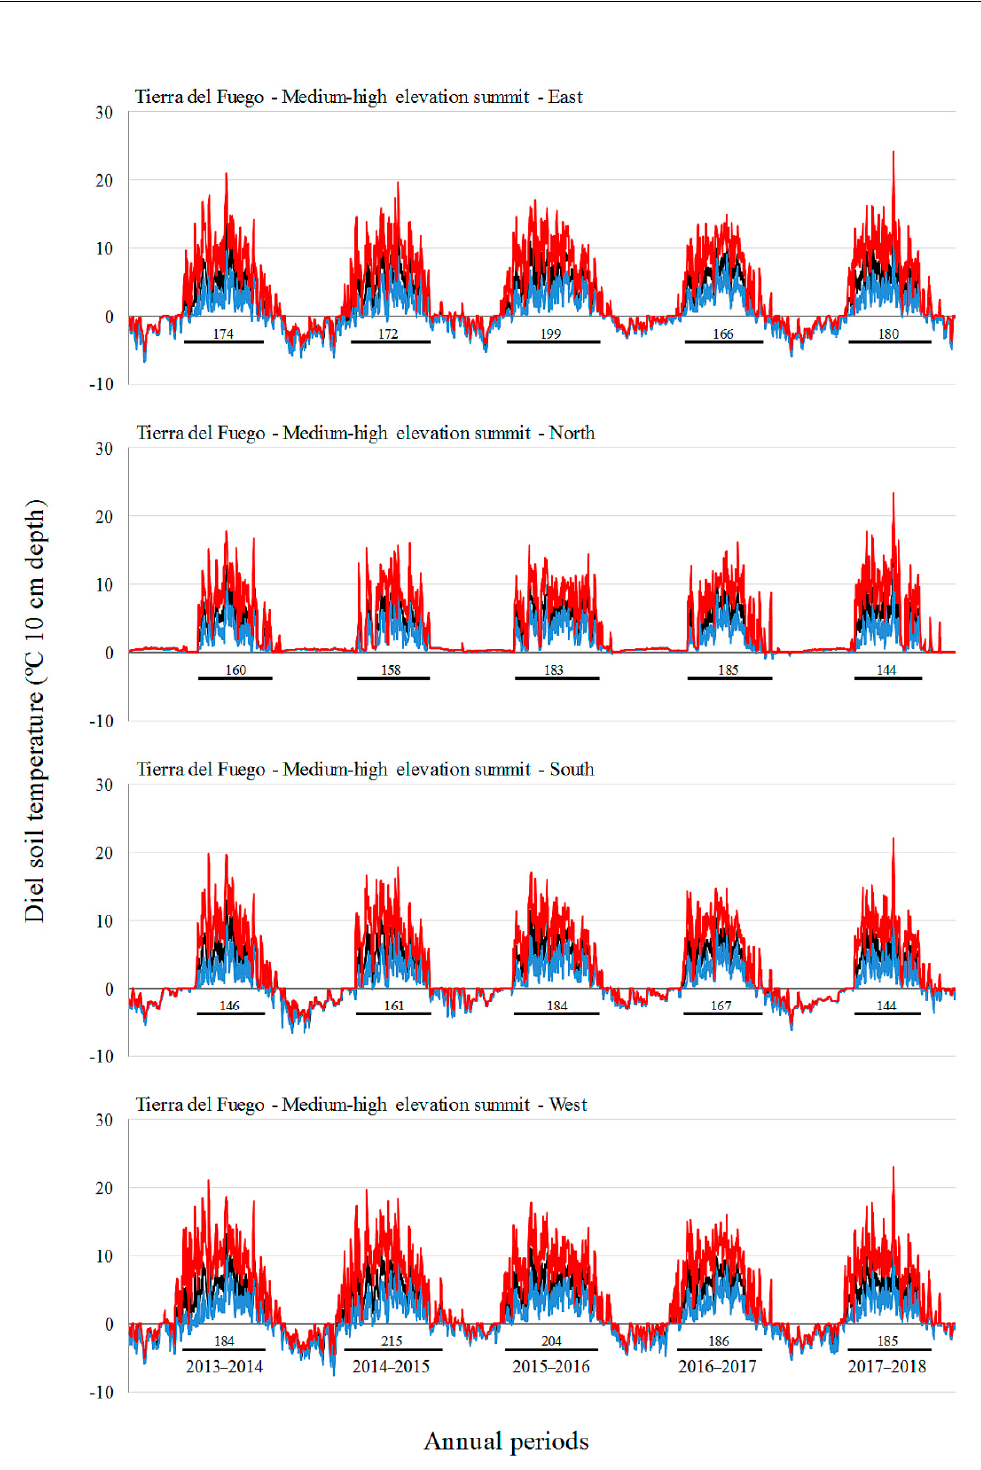
Figure A6. Diel soil temperature ( ◦ C) variation at 10 cm depth during the five studied annual periods (2013–2014 to 2017–2018) on medium-high elevation summit in Tierra del Fuego, showing separately different cardinal aspects (east, north, south, west). The length of the growing season is also indicated with horizontal black bars (numbers represent days). Black = mean temperature; blue = minimum temperature, and red = maximum temperature.